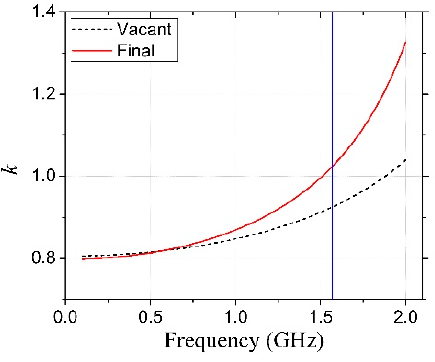
Figure 3. Variation of the coupling coefficient ( k ) with frequency for an air-bridged spiral inductor alone and for the proposed resonator.